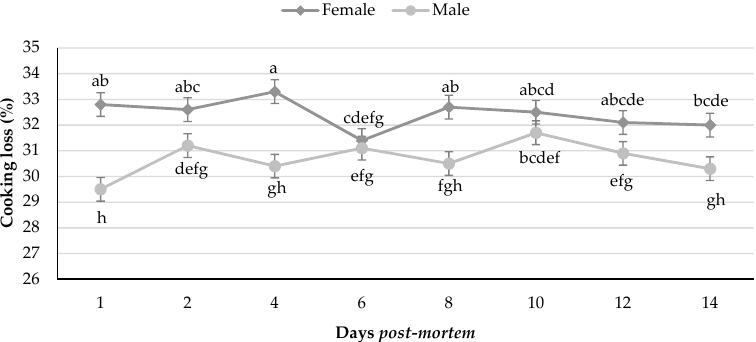
Figure 2. Effect of sex and ageing (days post-mortem ) on the cooking loss percentage of female and male impala longissimus thoracis et lumborum muscles. a–h Means with different superscripts differ from one another ( p ≤ 0.05). Error bars represent the standard error of the means.